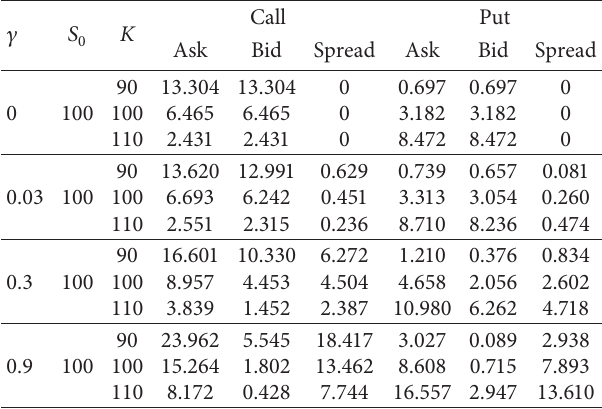
Table 1: The bid-ask prices of the European discrete geometric